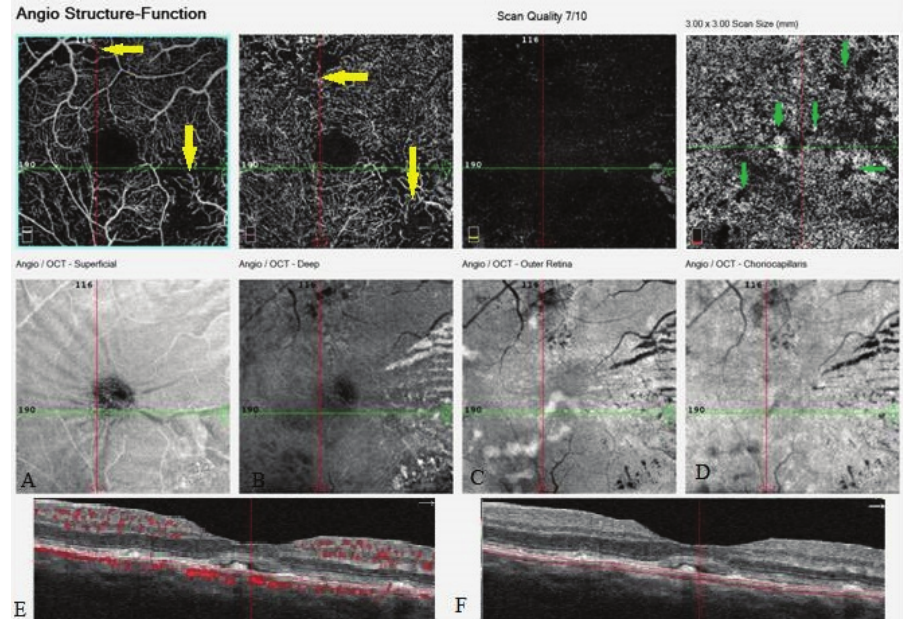
Figure 2. Optical coherence tomography angiography (OCTA) of the right eye. (A) Superficial capillary layer (and the related enface image: hyperreflective spots are seen in the inferonasal of the macula that are compatible with exudates) shows the area of the ischemia and capillary dropout in the inferonasal of the fovea (yellow arrow). (B) Deep capillary layer (and the related enface image: in the location of the deep capillary plexus, exudates as hyperreflective lines that are more prominent in the nasal of the macula in radial pattern) shows the enlargement of the foveal avascular zone and the ischemic area (yellow arrow). (C) The outer retina and the related enface image (the shadowing of exudates are visible as dark lines in outer retina). (D) The choriocapillaris layer (and the related enface image: the shadowing of exudates are also visible as a dark line in the choriocapillaris level and the other hyporeflective spots [Elschnig spots] are also visible in this level) shows hypointense spots (green arrow) that are compatible with Elschnig spots. The subretinal fluid and hyperreflective deposits (exudates) are also visible in B scans.